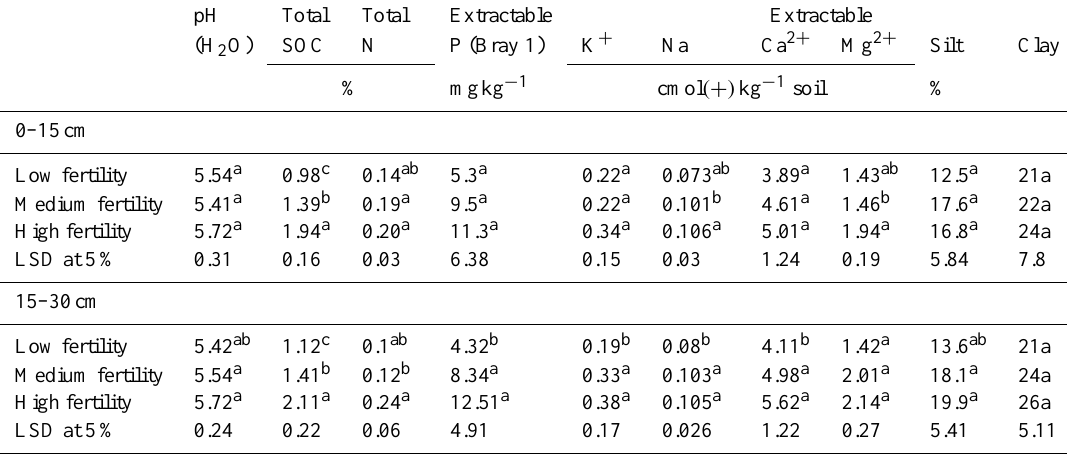
Table 1. Mean values of soil properties in 0–15 and 15–30cm soil depths for soil fertility categories derived using SOC ratings: low fertility ( < 1 . 2% SOC), medium fertility (1.2–1.7% SOC) and high SOC ( > 1 . 7%) for 30 sampled fields ( n = 10 for each category) of a Ferralsol in Uganda.